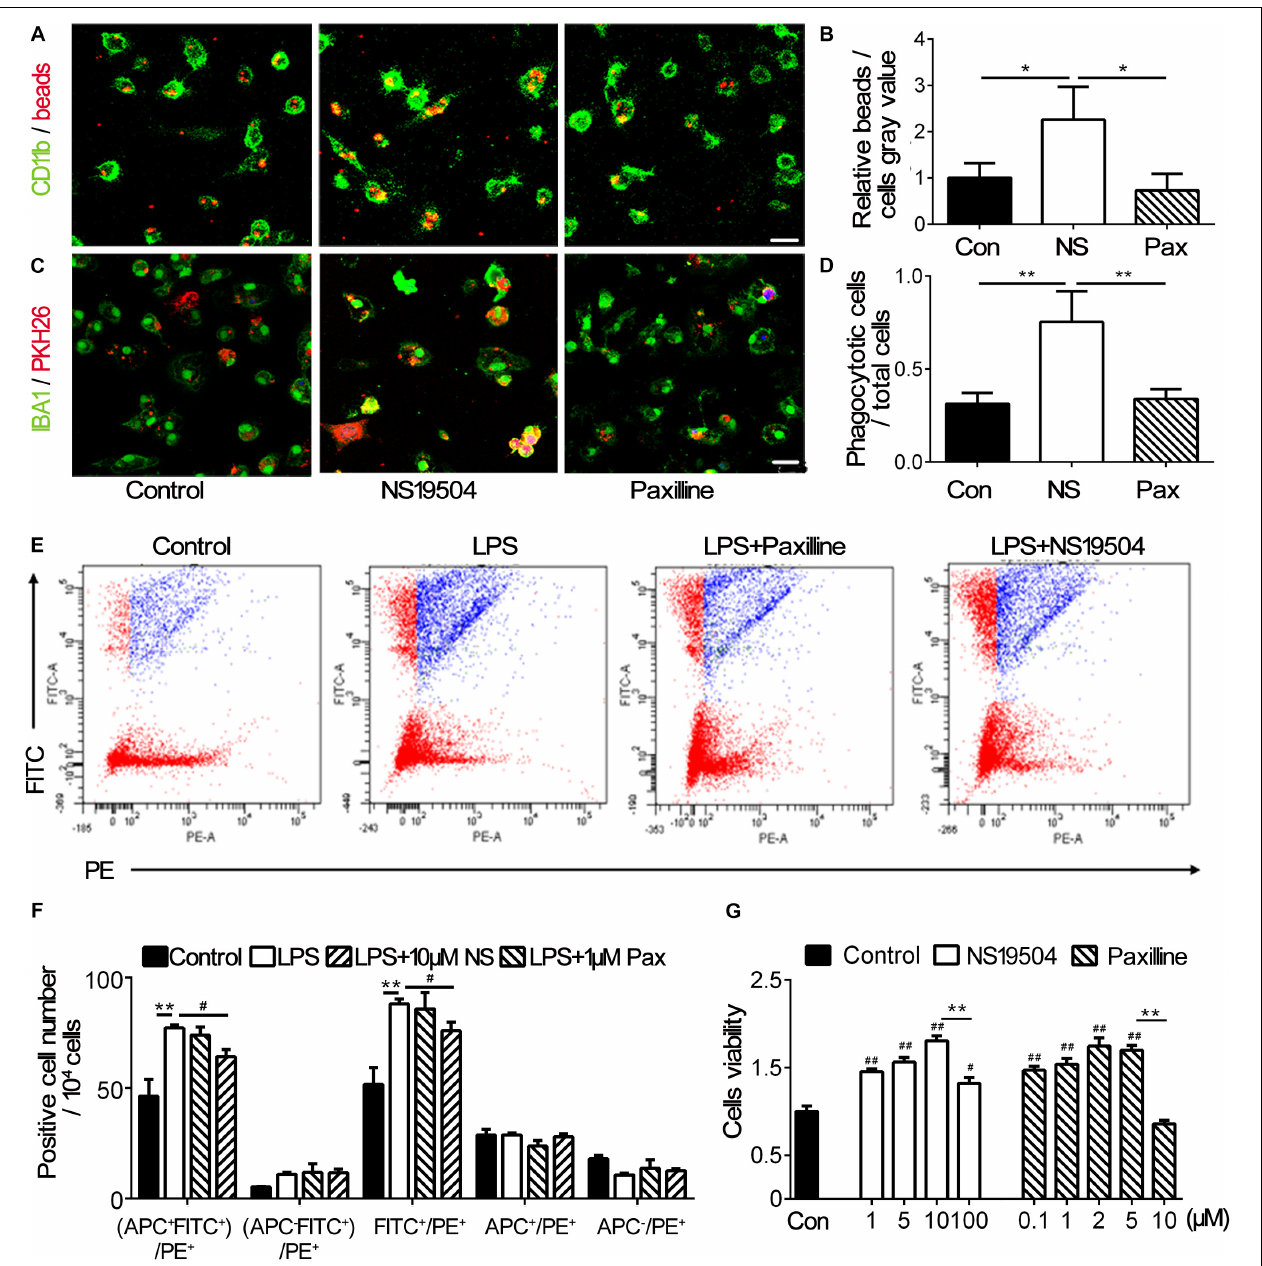
FIGURE 3 | BK channel activator NS19504 promoted microglial phagocytosis after OGD in primary culture . (A) Representative images of beads (red) phagocytosed by CD11b + microglia (green) after 1 h of OGD. Control group: primary microglia cultured with basic microglia medium; NS19504 group: primary microglia cultured with 10 µ M NS19504 in basic microglia medium; Paxilline group: primary microglia cultured with 1 µ M Paxilline in basic microglia medium. Scale bar = 25 µ m. (B) Bar graph showed that semiquantitative data of the relative bead density versus microglia. Data are mean + SE, n = 3 per group. * p < 0.05, control vs. NS19504 or Paxilline vs. NS19504 group. (C) Representative photomicrographs showed that neuronal debris (red) phagocytosed by microglia (green) in the NS19504- and Paxilline-treated mice following tMCAO. Scale bar = 25 µ m. (D) Bar graph shows semiquantitative data of the proportion of microglia that phagocytose neuronal debris. Data are mean + SE, n = 3 per group. * p < 0.05, NS19504 vs. control or Paxilline vs. NS19504 group. (E) Representative photomicrographs show FITC and PE-positive cells. FITC-labeled beads were phagocytosed by PE-labeled microglia. Primary microglia were divided into the control group (basic microglia medium); LPS group (200 ng/ml LPS); LPS + NS19504 group (200 ng/ml LPS and 10 µ M NS19504); and LPS + Paxilline group (200 ng/ml LPS and 1 µ M Paxilline). (F) Bar graph shows semiquantitative analysis of the proportion of microglia that phagocytose beads. Data are mean + SE, n = 3 per group. ** p < 0.01, compared with the control group. # p < 0.05, compared with the Paxilline group. (G) Bar graph shows the result of CCK-8 assay in the primary microglia without or with different concentrations of Paxilline and NS19504 for 12 h of OGD. Data are mean ± SE, n = 3 per group. # p < 0.05, ## p < 0.01, compared with the control group. * p < 0.05, ** p < 0.01; NS represents for NS19504, and Pax represents for